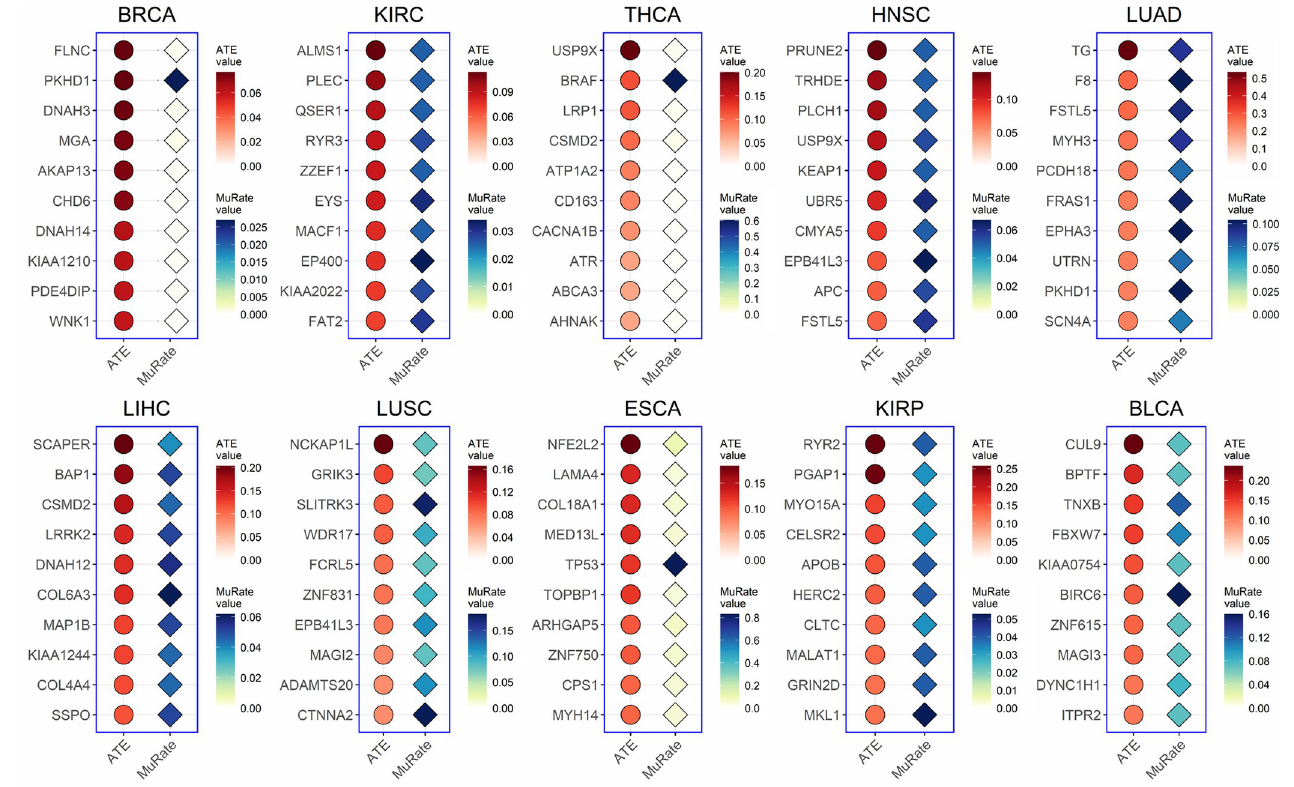
Fig 4. Top 10 mutations with the highest causal effect on EMT process in 10 cancers. The figure shows the ATE value and the mutation rate of each predicted key